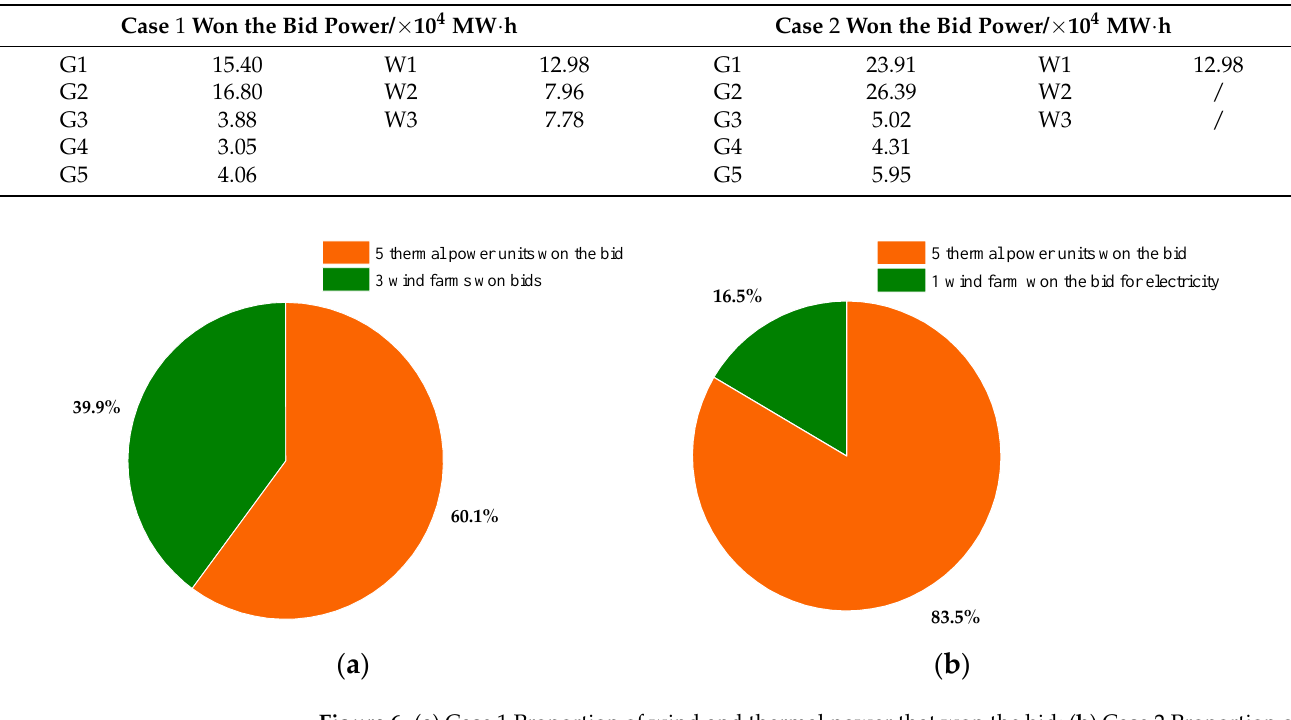
Figure 6. ( a ) Case 1 Proportion of wind and thermal power that won the bid; ( b ) Case 2 Proportion of wind and thermal power that won the bid.